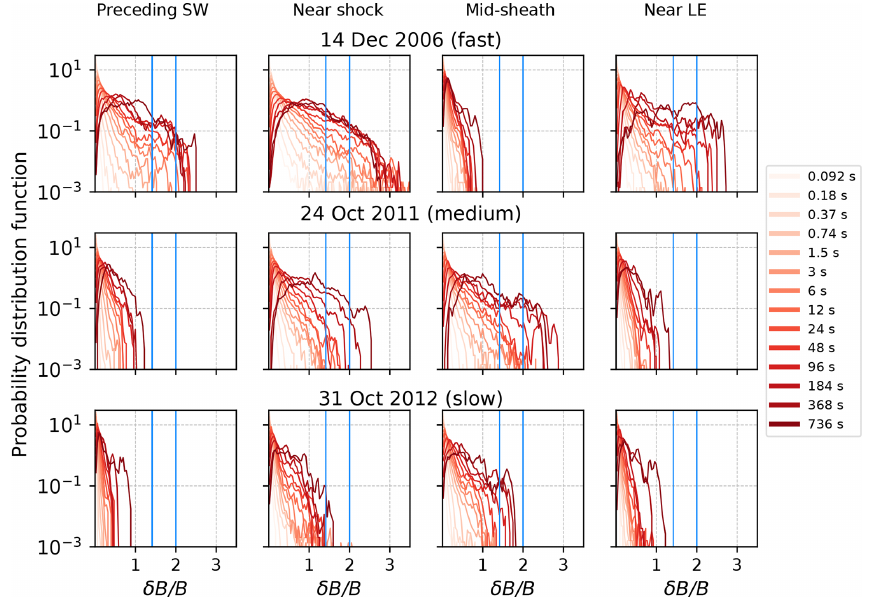
Figure 2. Probability distribution functions of δB/B for different timescales (cid:49)t (shown as curves in different colours) for (top) 14 Decem- ber 2006, (middle) 24 October 2011, and (bottom) 31 October 2012 events. The leftmost columns give the results for the solar wind preceding the shock, and the following three columns represent the three different sheath